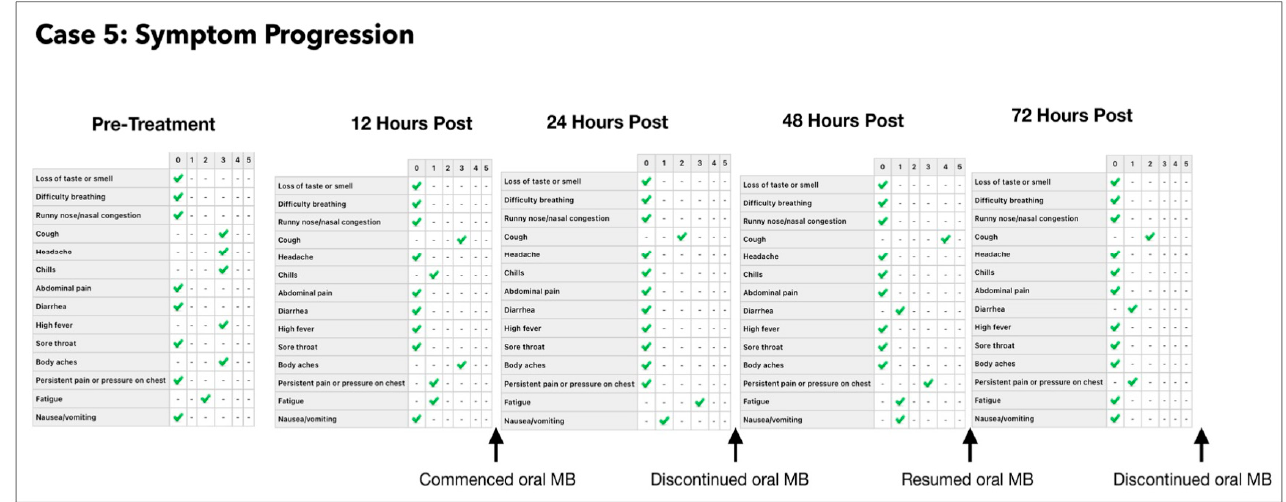
Figure 12. Shows the symptom progression of subject five pre-treatment, 12 h, 24 h and 72 h post- treatment based on symptom scale ranging from 0 – 5.